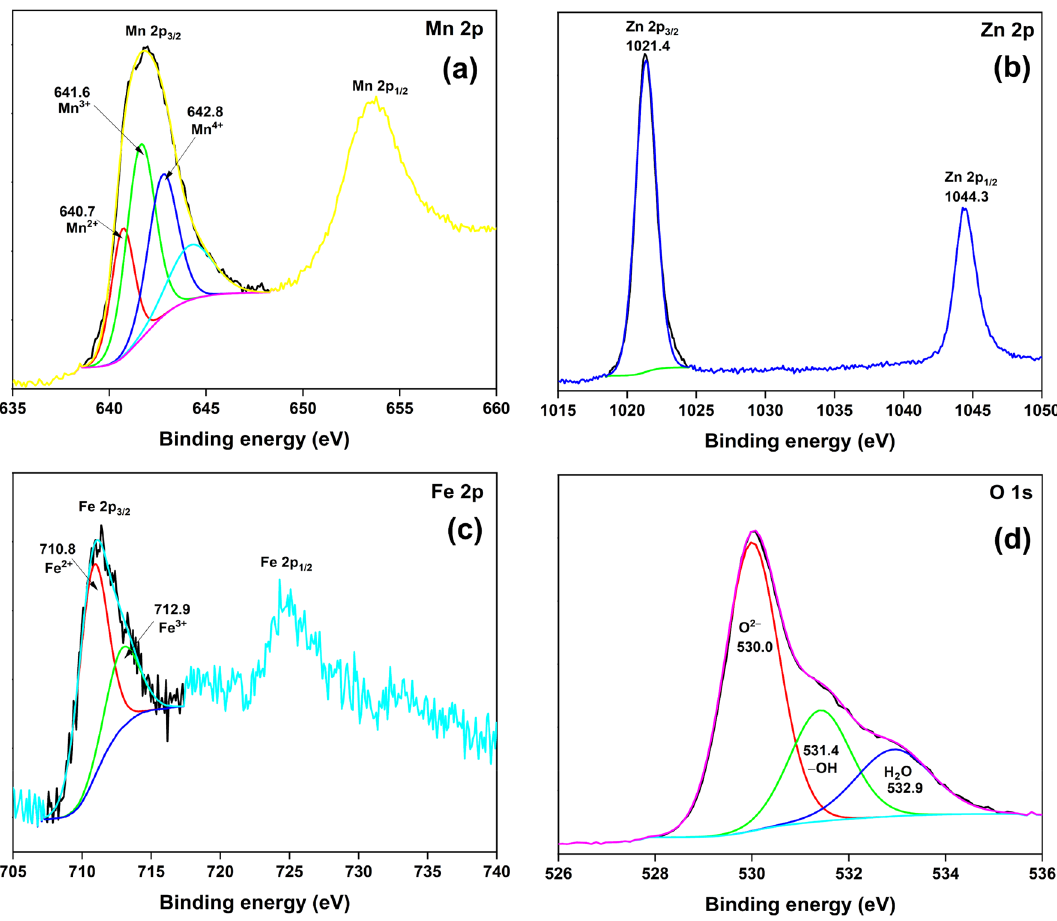
Figure 3. High-resolution XPS ( a ) Mn 2p; ( b ) Zn 2p; ( c ) Fe 2p; ( d ) O 1 s spectra of